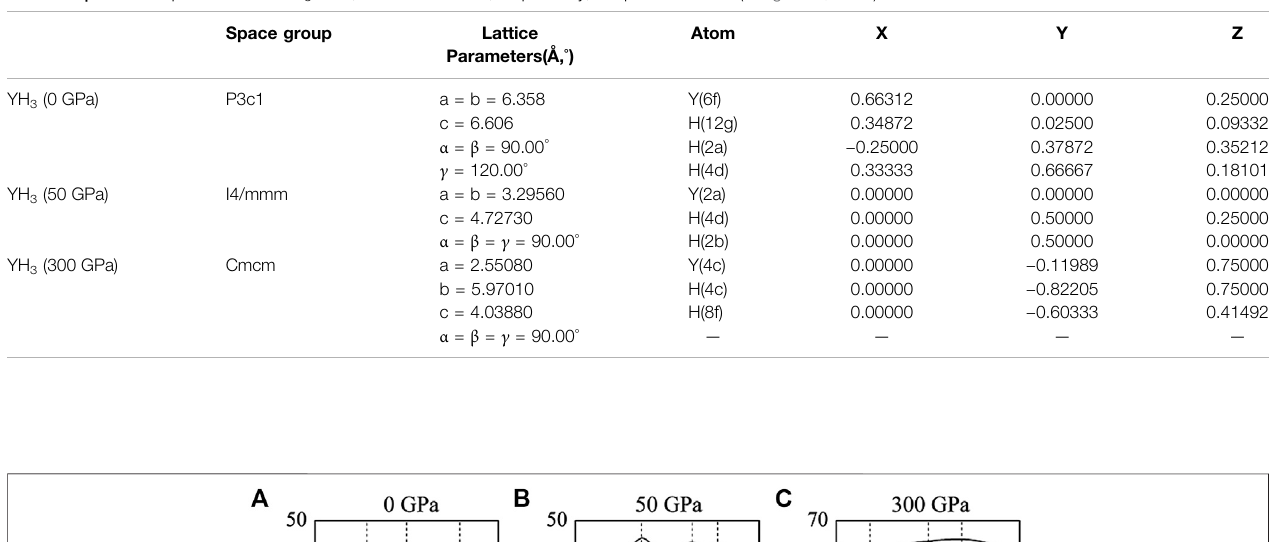
TABLE 1 | Structural parameters of YH 3 for 0, 50 and 300 GPa, respectively, adapted from Ref. (Peng et al., 2017).